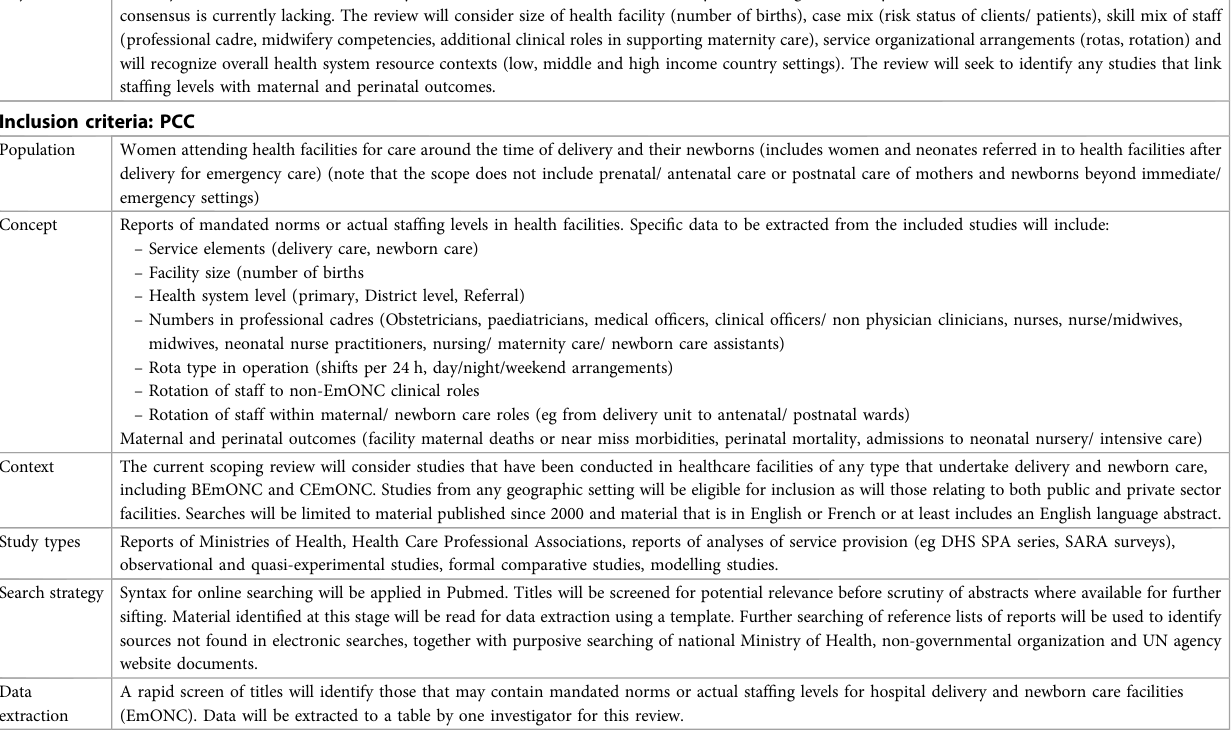
TABLE 1 Scoping review inclusion criteria related to the objectives. Topic